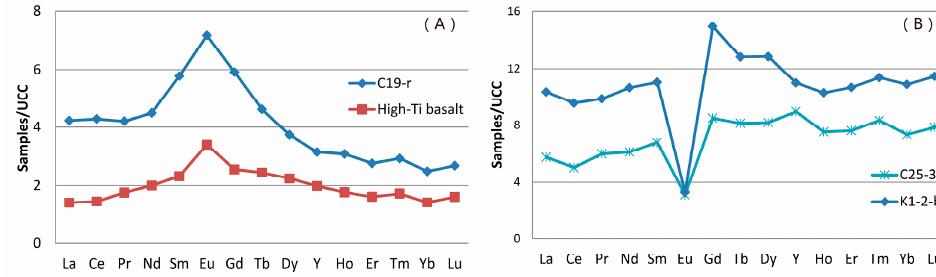
Figure 17. Distribution patterns of REE in the ( A ) high-Ti basalts [10] and C19-r; and ( B ) the coal in Lvshuidong [5] and C25-3. REE are normalized by Upper Continental Crust (UCC) [32]. Table 5. The trace element ( μ g/g) in sample C19-r compared with high/low Ti basalts [10]. Samples C19-r Low-Ti Basalt 289